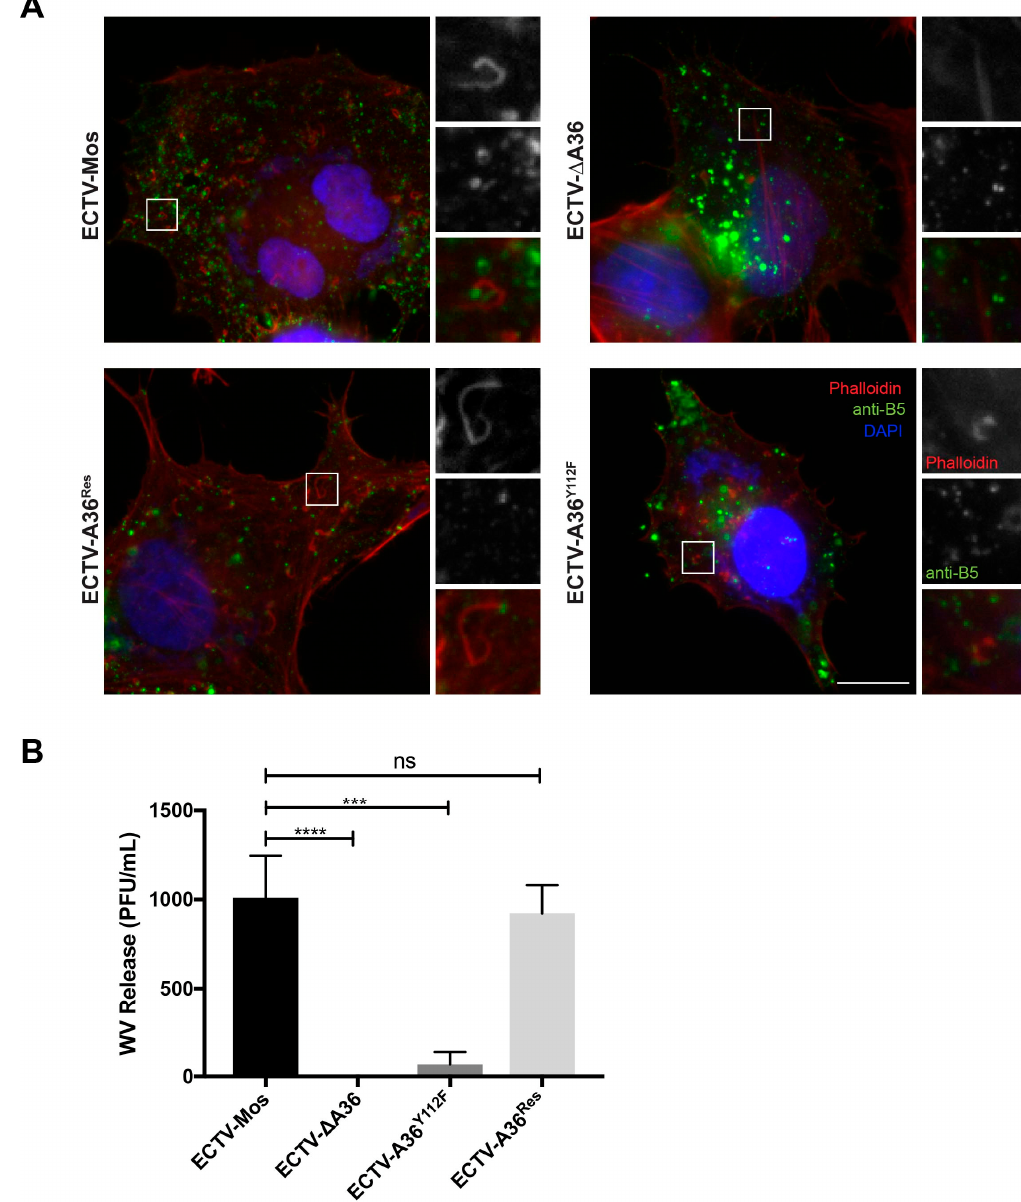
Figure 3. Release of WV is reduced in the absence of actin-based motility. ( A ) HeLa cells were infected with the indicated viruses and fixed at 16 hpi, and probed with anti-B5 (green), phalliodin (red), and DAPI (4 ′ ,6-diamidino-2-phenylindole) (blue) and visualized by immunofluorescence microscopy. Scale bar: 10 μ m. ( B ) BSC-1 cells were infected at a multiplicity of infection (MOI) of 0.1 and supernatants collected at 24 hpi and centrifuged at 10,000 rpm for 10 min to remove cells and cellular debris. Plaque assays were then performed in BSC-1 cells infected with serially diluted supernatant and overlaid with 1.5% carboxymethyl cellulose in minimal essential medium (CMC-MEM) and stained at six days pi with crystal violet to quantify plaques to determine viral titre. Data for three experimental replicates were pooled. (**** p < 0.0001; *** p < 0.001; ns, non-significant; unpaired t -test).